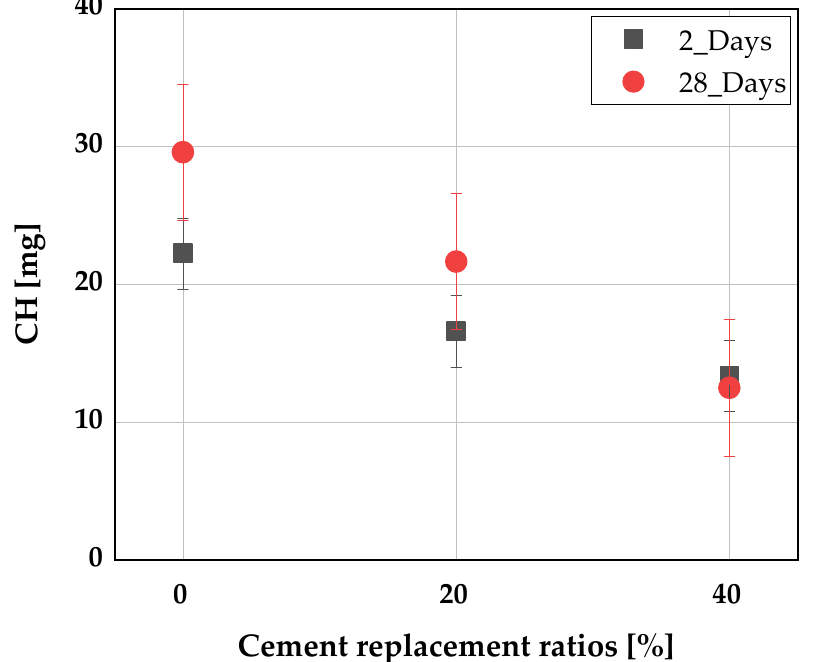
Figure 11. DTA curves of SC-P at 2 days ( a ) and 28 days ( b ) of hydration (E = ettringite, Mc = monocarboaluminat, Hc = hemicarboaluminate).